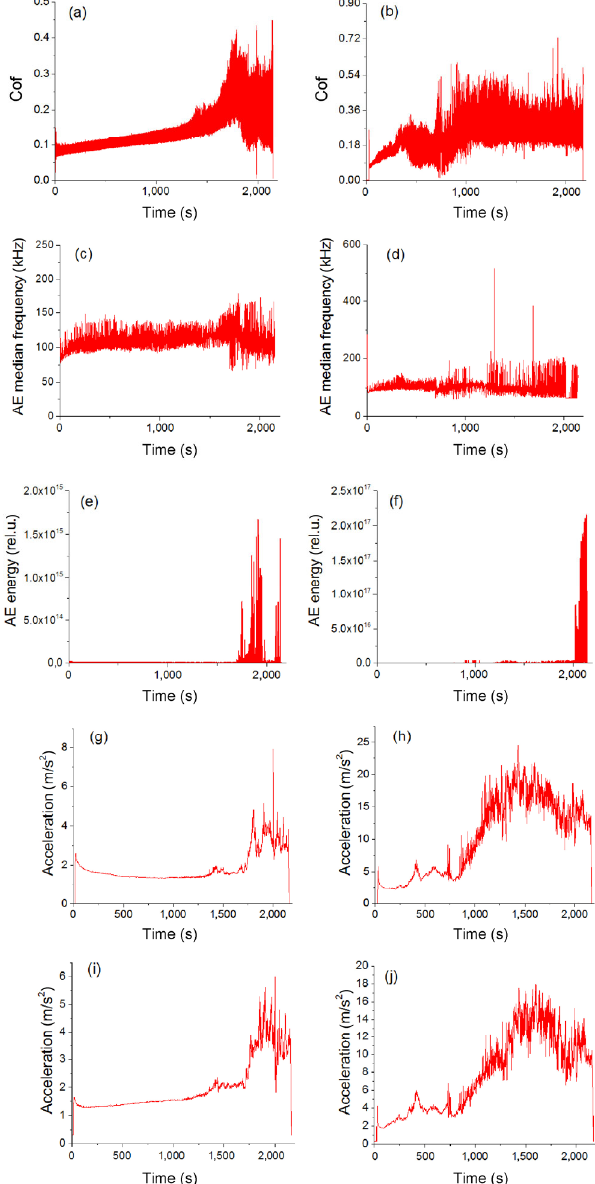
Fig. 2 Time dependencies of friction coefficient ((a), (b)), AE median frequency ((c), (d)), AE energy ((e), (f)), and vertical ((g), (h)) and horizontal ((i), (j)) vibration acceleration RMS for Y-TZP ceramics obtained in sliding at 1 m/s, 13 N ((a), (c), (e), (g), (i)) and 26 N ((b), (d), (f), (h), (j)) normal load. disappear (Fig. 1(d)). High-frequency 1 MHz